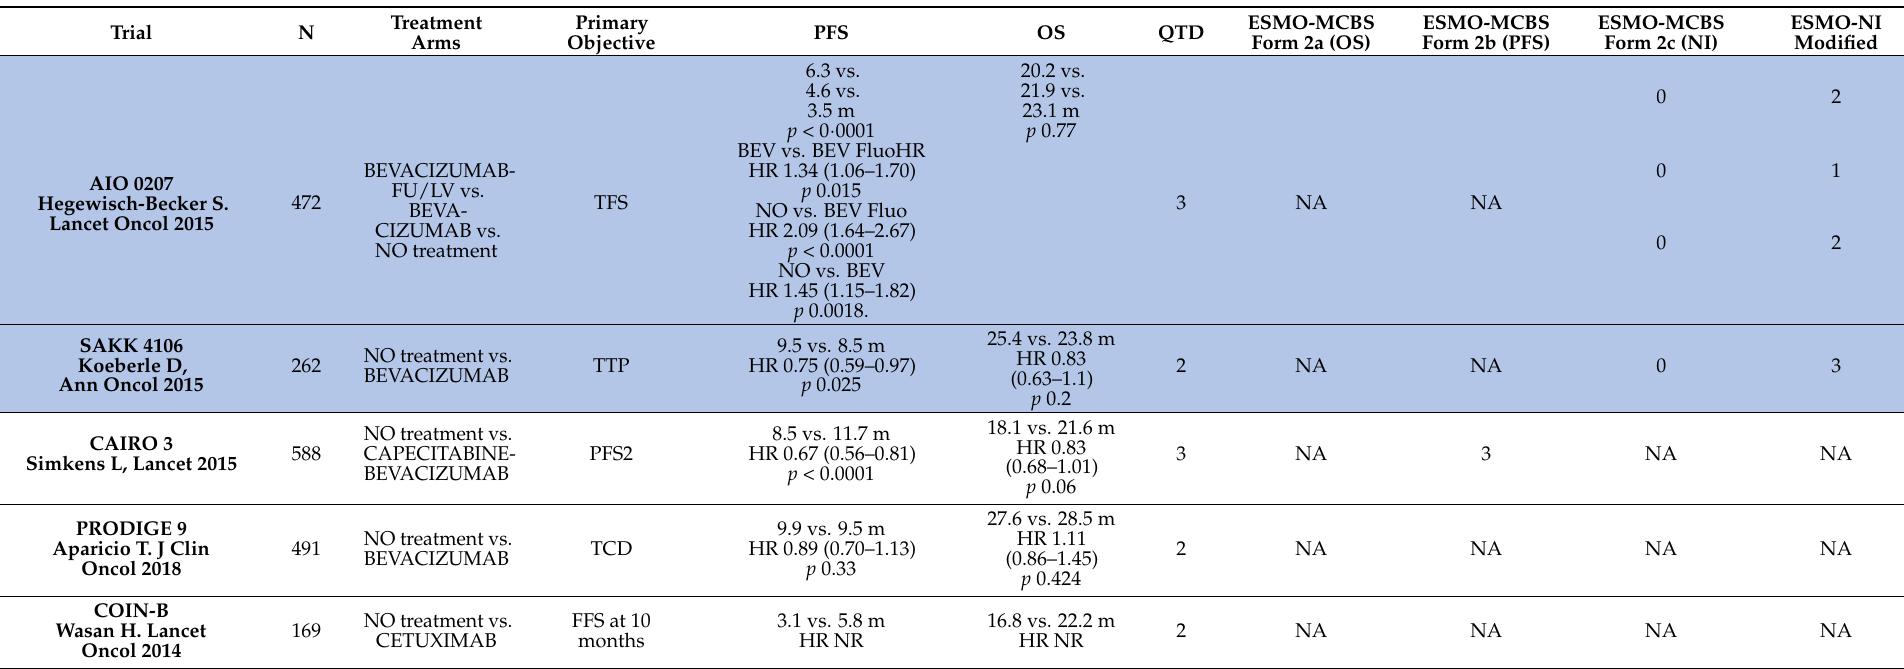
Table 8. Treatment with continuous CT doublets plus monoclonal antibodies (MAbs) vs. intermittent